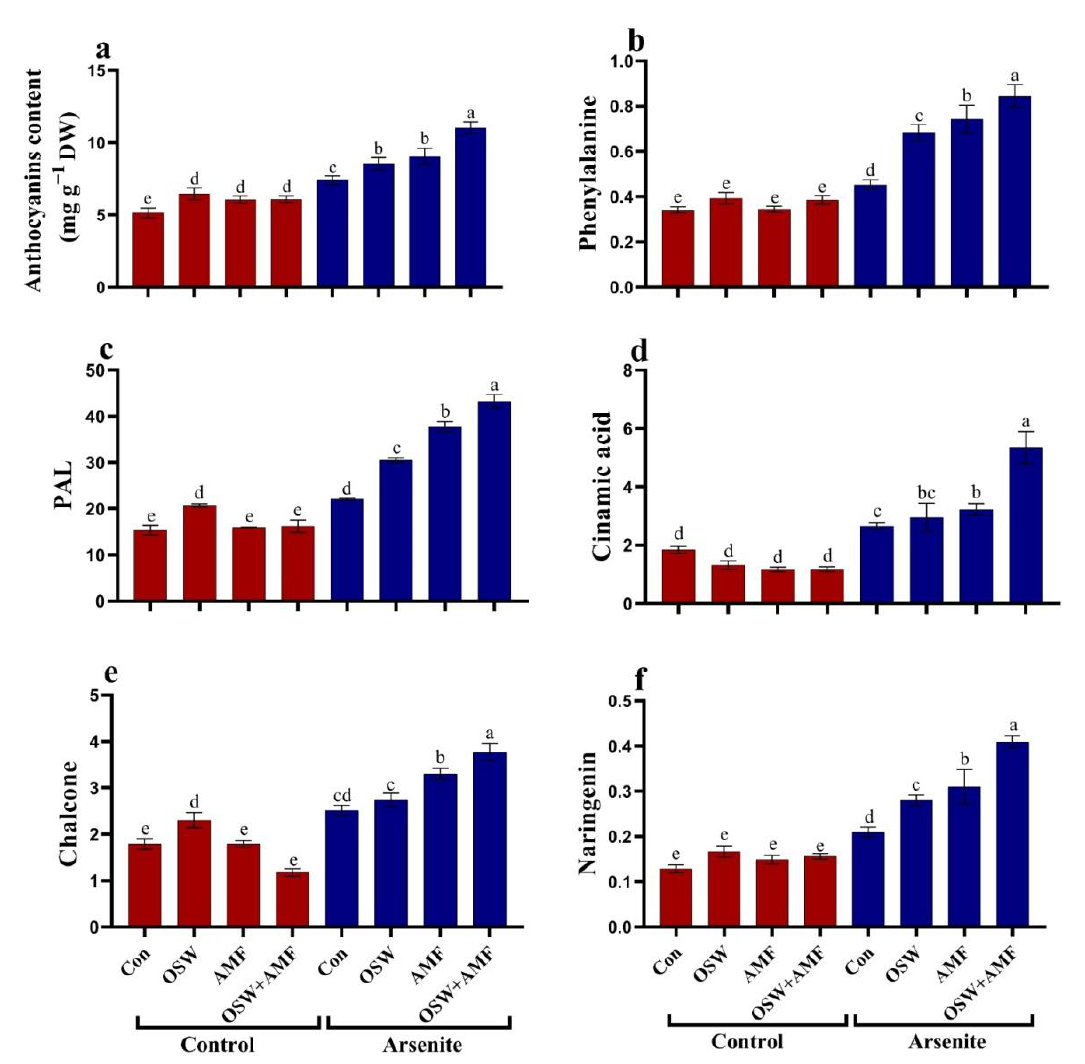
Figure 7. The influence of olive solid waste (OSW) and arbuscular mycorrhizal fungi (AMF), combination (OSW + AMF) on anthocyanin metabolism (Anthocyanin ( a ), Phenylalanine ( b ), Phenylalanine aminolyase (PAL) ( c ), Cinnamic acid ( d ), Chalcone ( e ), and Naringenin ( f ) in wheat plants growing under As stress. Fishers test at p < 0.05 reveals significant variations in means ( ± standard deviation), which are different letters on the same bars.